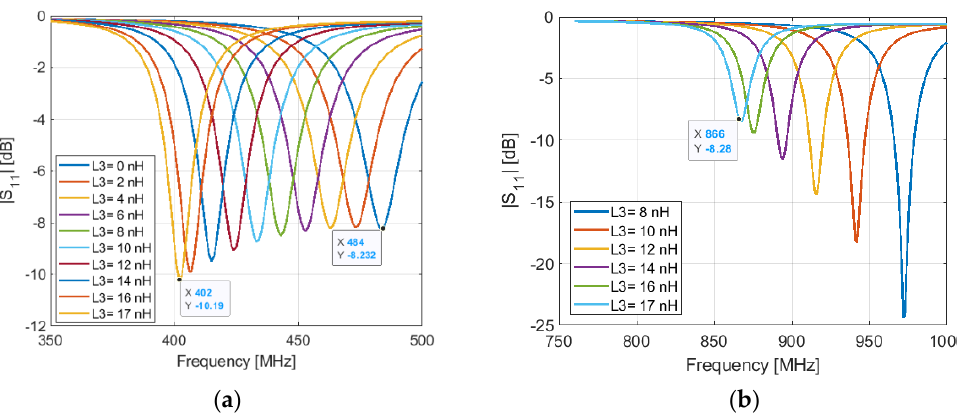
Figure 4. Simulated input reflection coefficient of the antenna for varied parameter L3 when